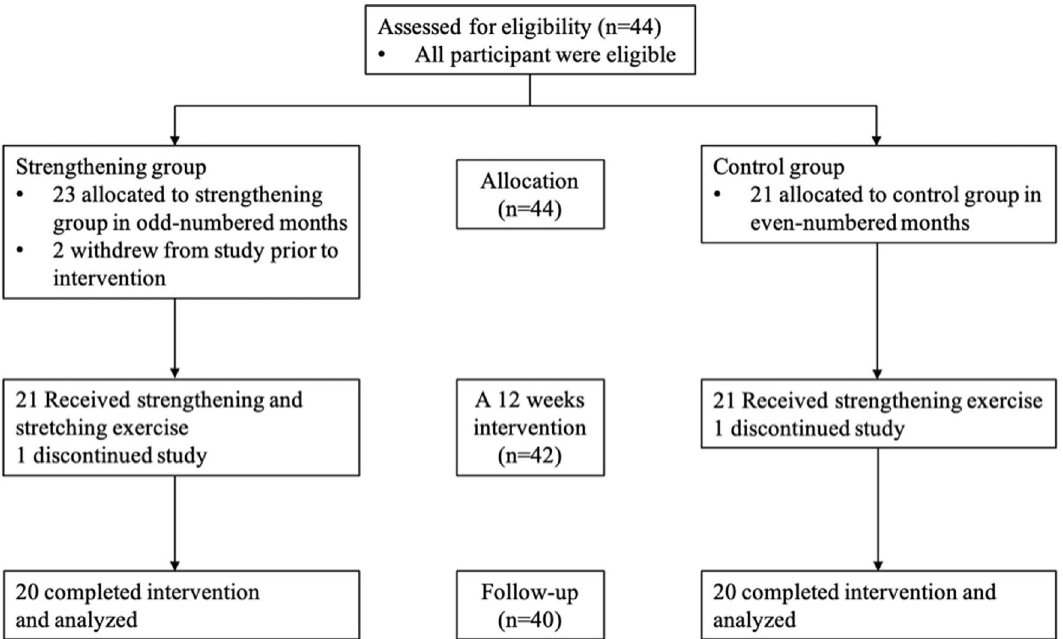
Figure 5. Flow of the participants throughout the trial. The participants were divided into two groups as follows: the strengthening group and the control group. A total of 40 participants (20 in each group) were